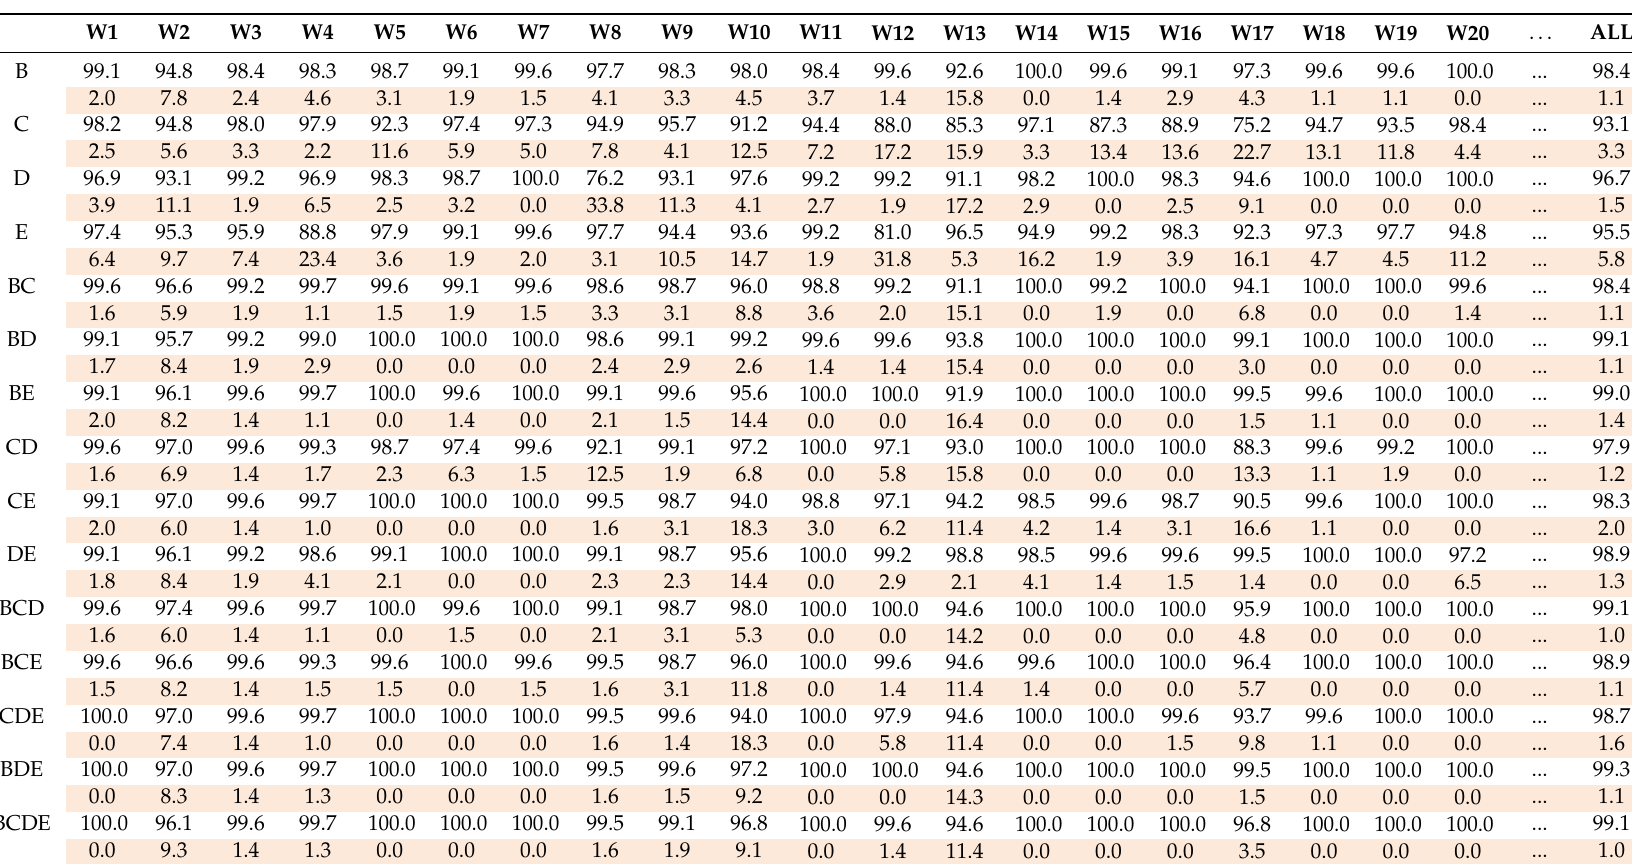
Table 4. Table of recognition R s_V (in %) of all motor activities for volunteers V1 ÷ V20 in test set for sensors B ÷ E and their sets. Calculation errors U s_V are placed in orange